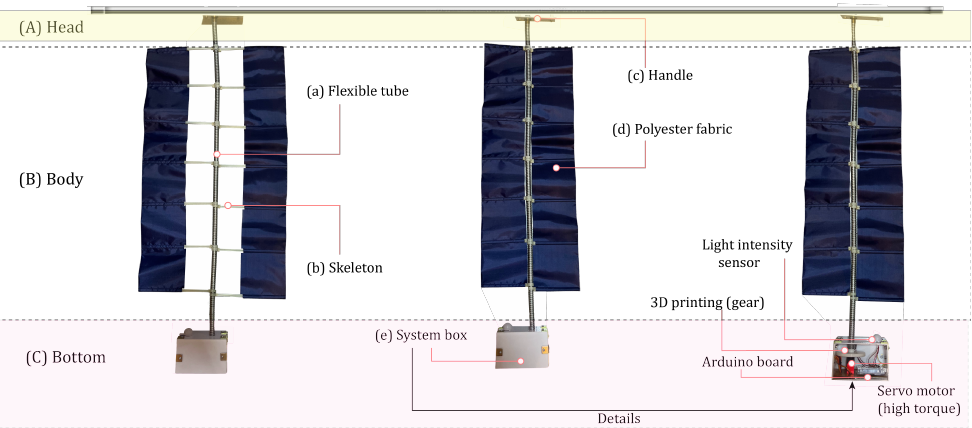
Figure 14. The model for the new design of kinetic façade (version 2: twisting movement) fabrication.